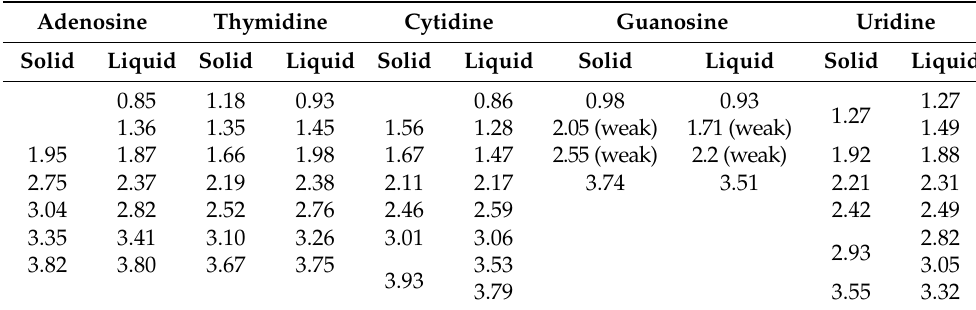
Table 2. Vibration frequencies (in THz) of five nucleoside solid and liquid samples. Adenosine